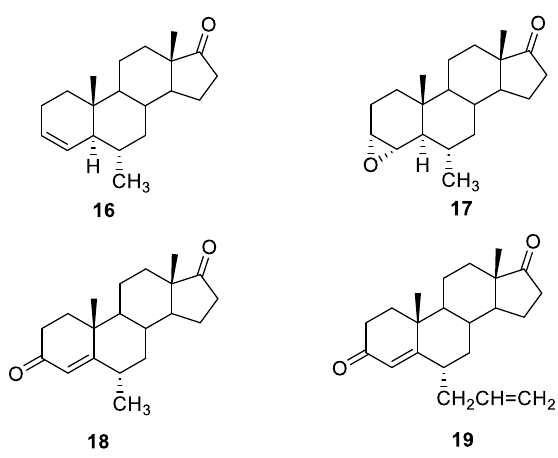
Figure 12. Potential multitarget AI/SERM steroidal compounds.